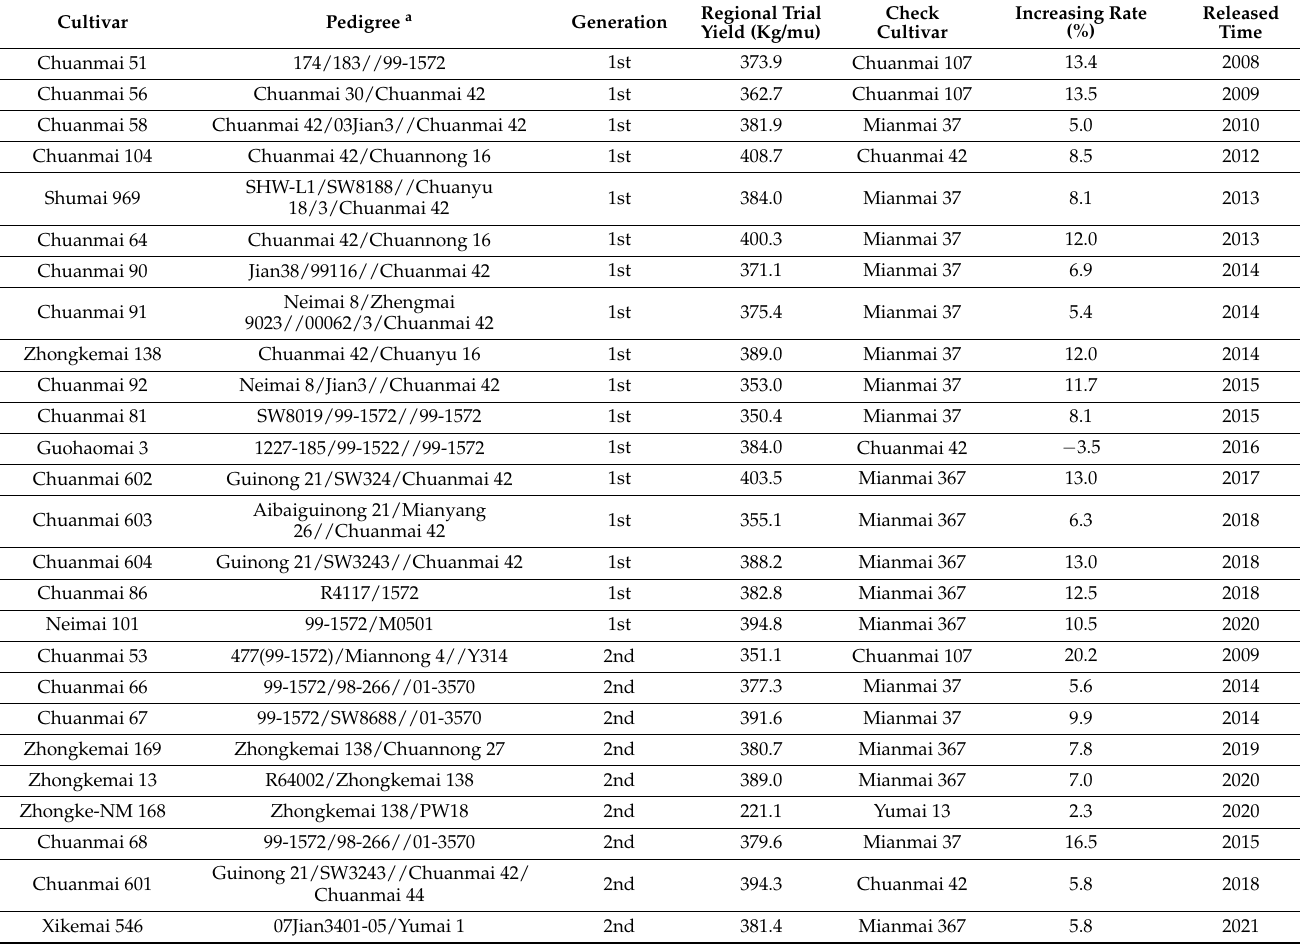
Table 3. Cultivars released from the cross involving Chuanmai 42 in southwestern